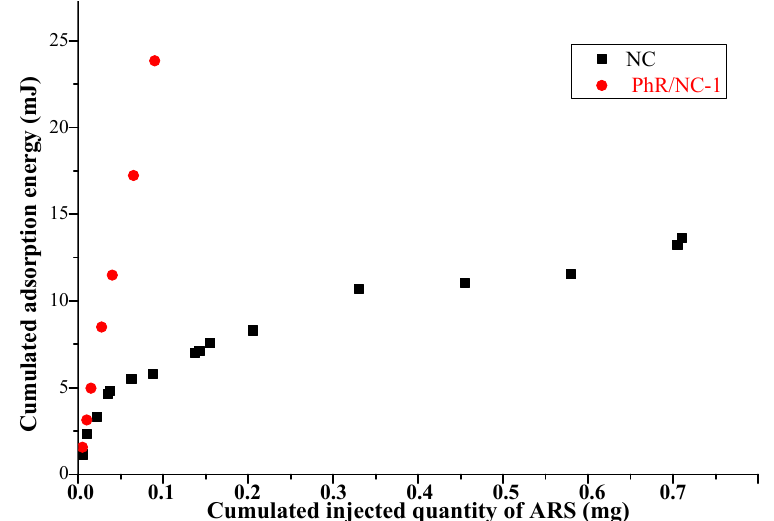
Figure 8. Effect of contact time on the adsorption capacity of ARS on NC and PhR/NC-1 carbons (initial concentration: 200 mg ∙ L − 1 , 25 °C, pH: 3).